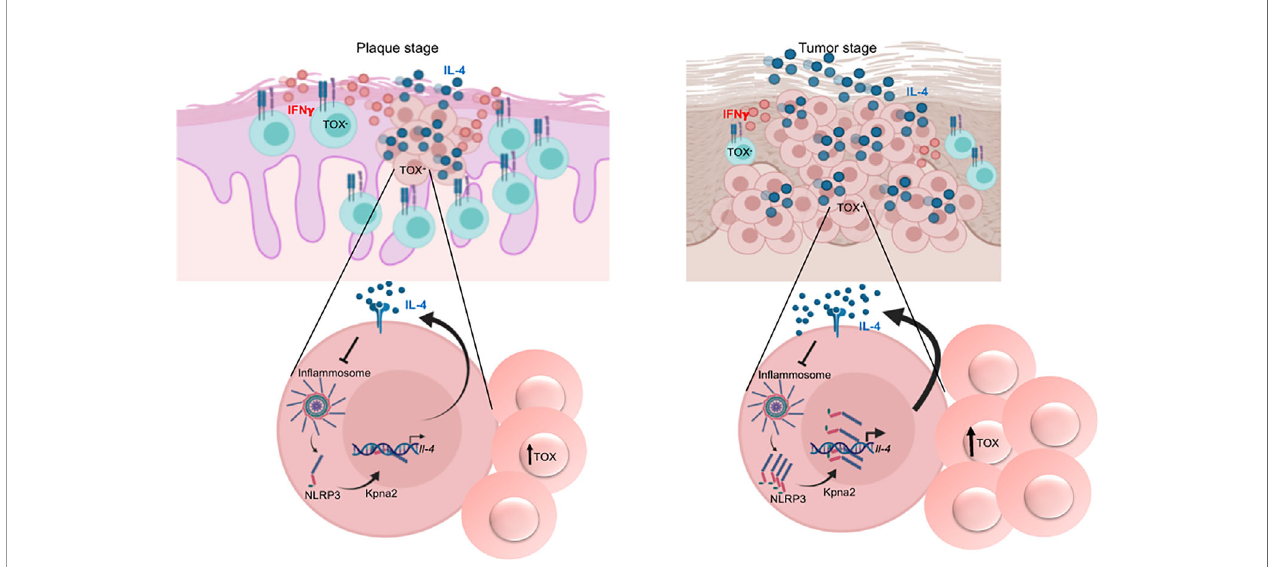
FIGURE 8 | Model of the mechanism of regulation of IL-4 expression in CTCL and its role in the progression of the disease. TOX + CD4 + T cells that express IL-4 are present beginning in the early stage of the disease. Unassembled NLRP3 translocates to the nucleus and binds to the il-4 promoter, thus regulating IL-4 expression. Elevated levels of IL-4 then accelerate disease progression because a) NLRP3 nuclear localization is further triggered through inhibition of in fl ammasome assembly and b) TOX expression and TOX + cell proliferation are promoted. This mechanism is ampli fi ed in the late stages of the disease, thus promoting the dominance of a Th2 milieu. Created with